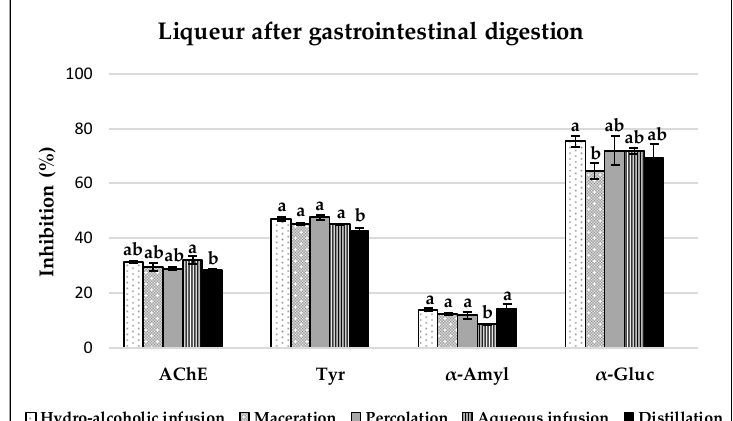
Figure 4. Enzyme [acetylcholinesterase (AchE), tyrosinase (tyr), α -amylase ( α -amyl) and α - glucosidase ( α -gluc)] inhibitory capacities of undigested carob liqueurs obtained with different extraction methods. For each enzyme (AchE, tyr, α -amyl, or α -gluc) inhibition method, values marked with different letters indicate a significant difference ( p < 0.05).